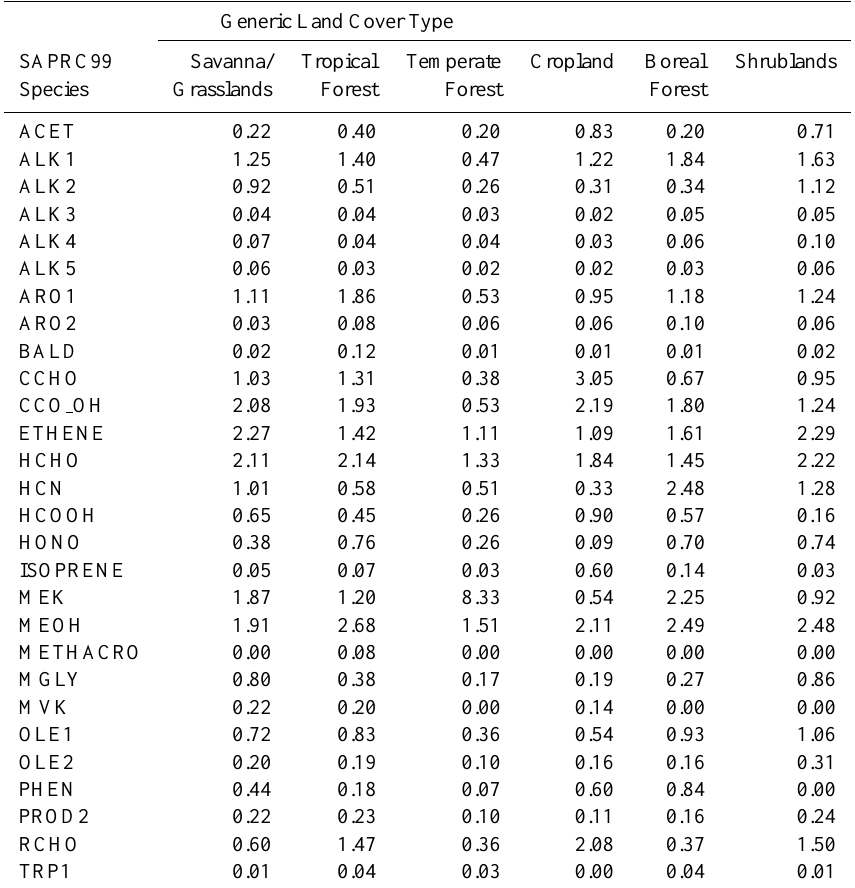
Table 4. Factors to convert NMOC Emissions (kg day − 1 ) to SAPRC99 chemical species (moles-species day − 1 ) for each generic land cover class in which a fire burns.